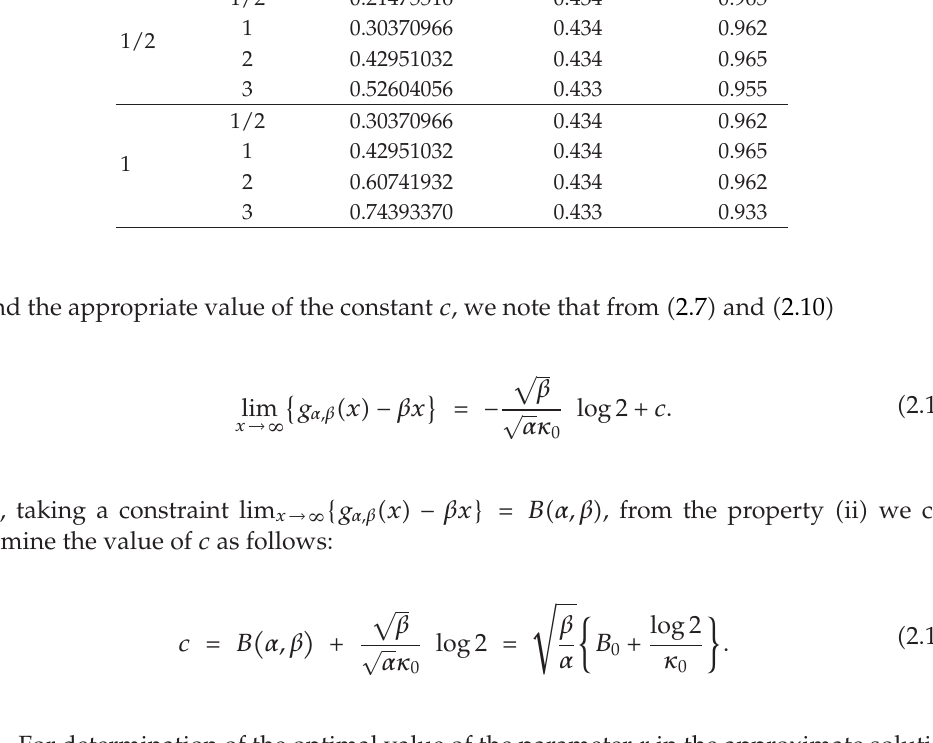
Table 2: Numerical optimal values of the parameter r and maximum relative % errors of the two-term approximate solution g α,β (cid:3) x (cid:4) for each value of α and β . α β r ∗ M (cid:7) 0 (cid:8) g α,β M (cid:7) 1 (cid:8) g α,β 1 / 2 0.21475516 0.434 0.965 1 / 2